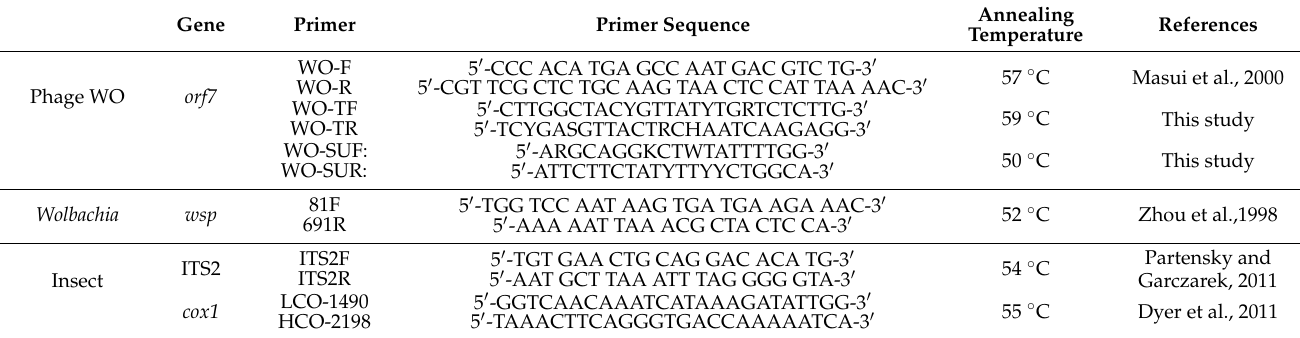
Table 1. Primers used in this